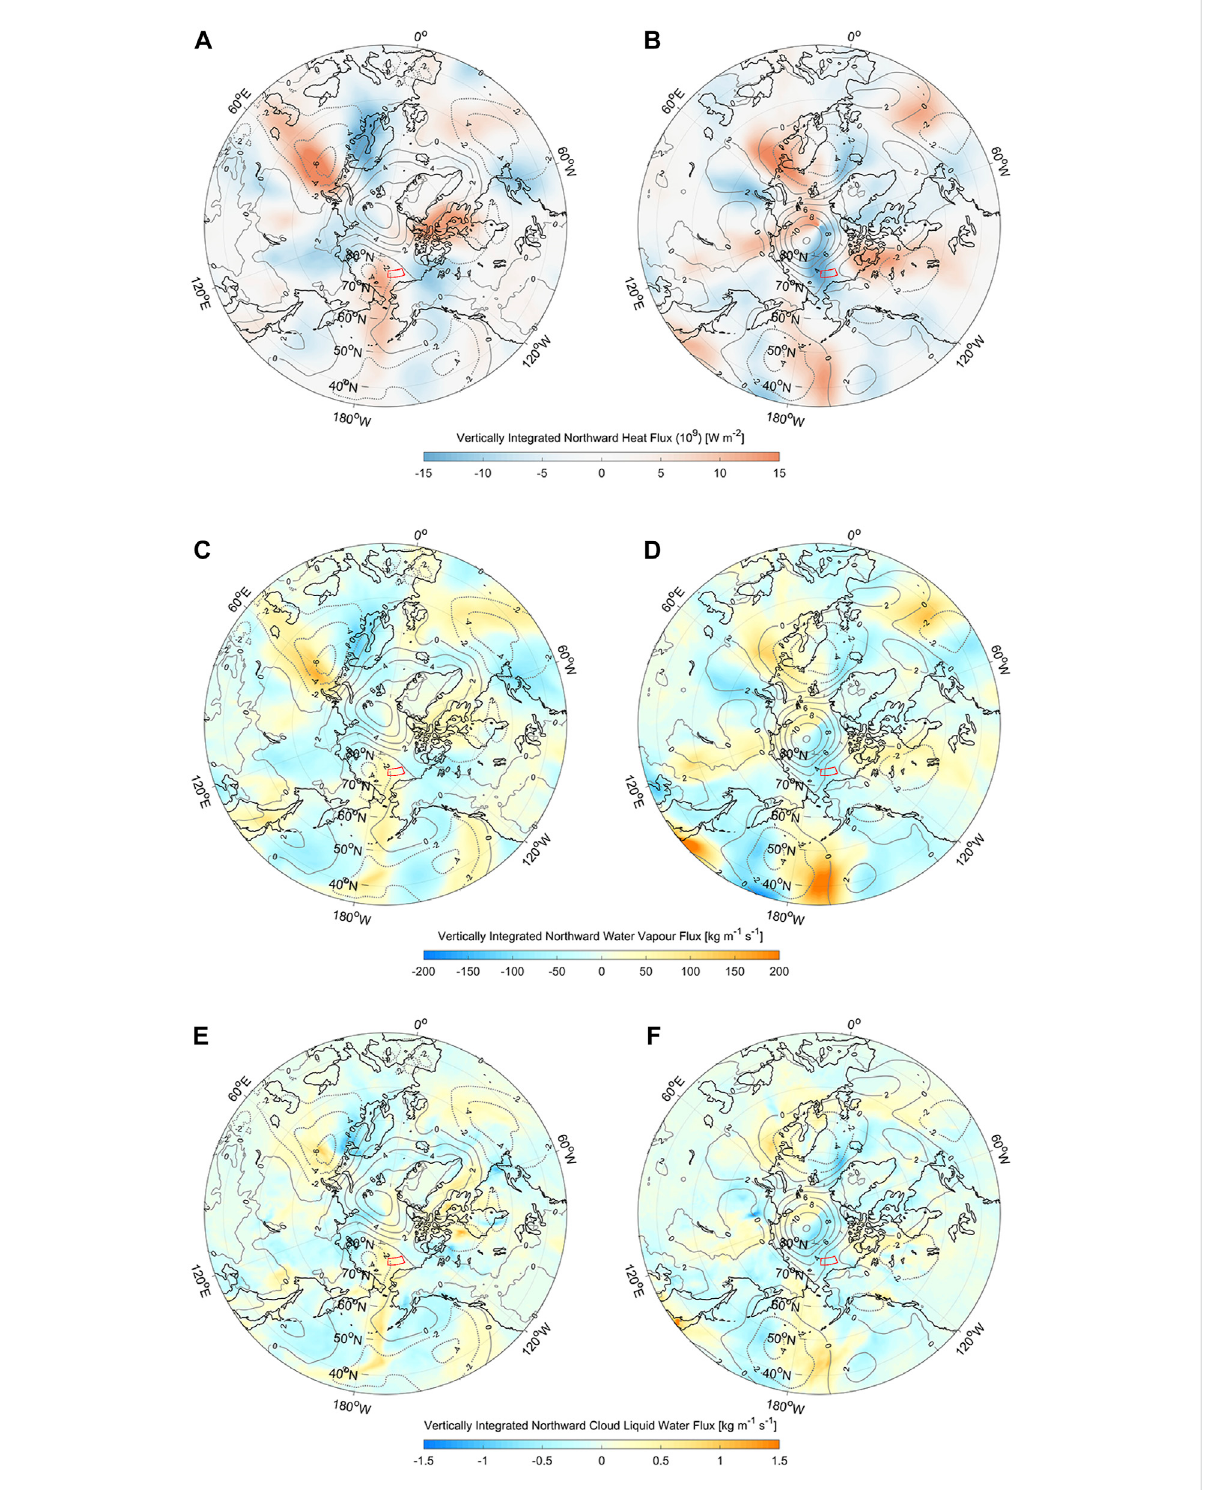
FIGURE 6 The MSLP anomaly fi eld (contour, the solid gray line is the positive anomaly, the gray dashed line is the negative anomaly) in July 2019 (A,C,E) and July 2020 (B,D,F) superimposed on the anomaly of the vertically integrated northward heat fl ux (A,B) , vertically integrated northward water vapor fl ux (C,D) and the vertically integrated northward cloud liquid water fl ux (E,F) . Red polygons encapsulate areas represents the study area of this